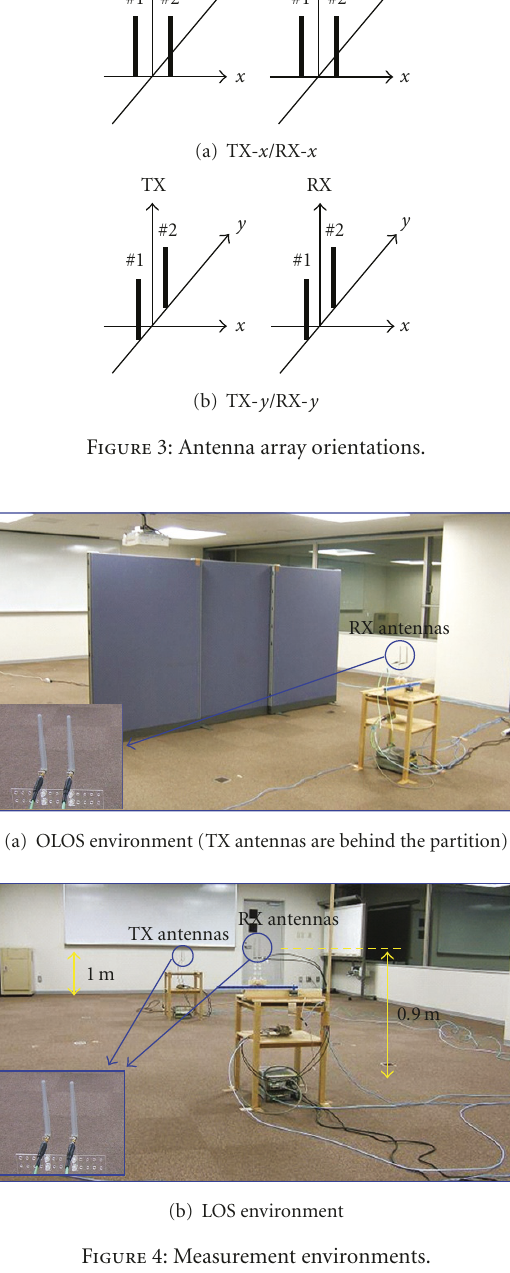
Figure 4: Measurement